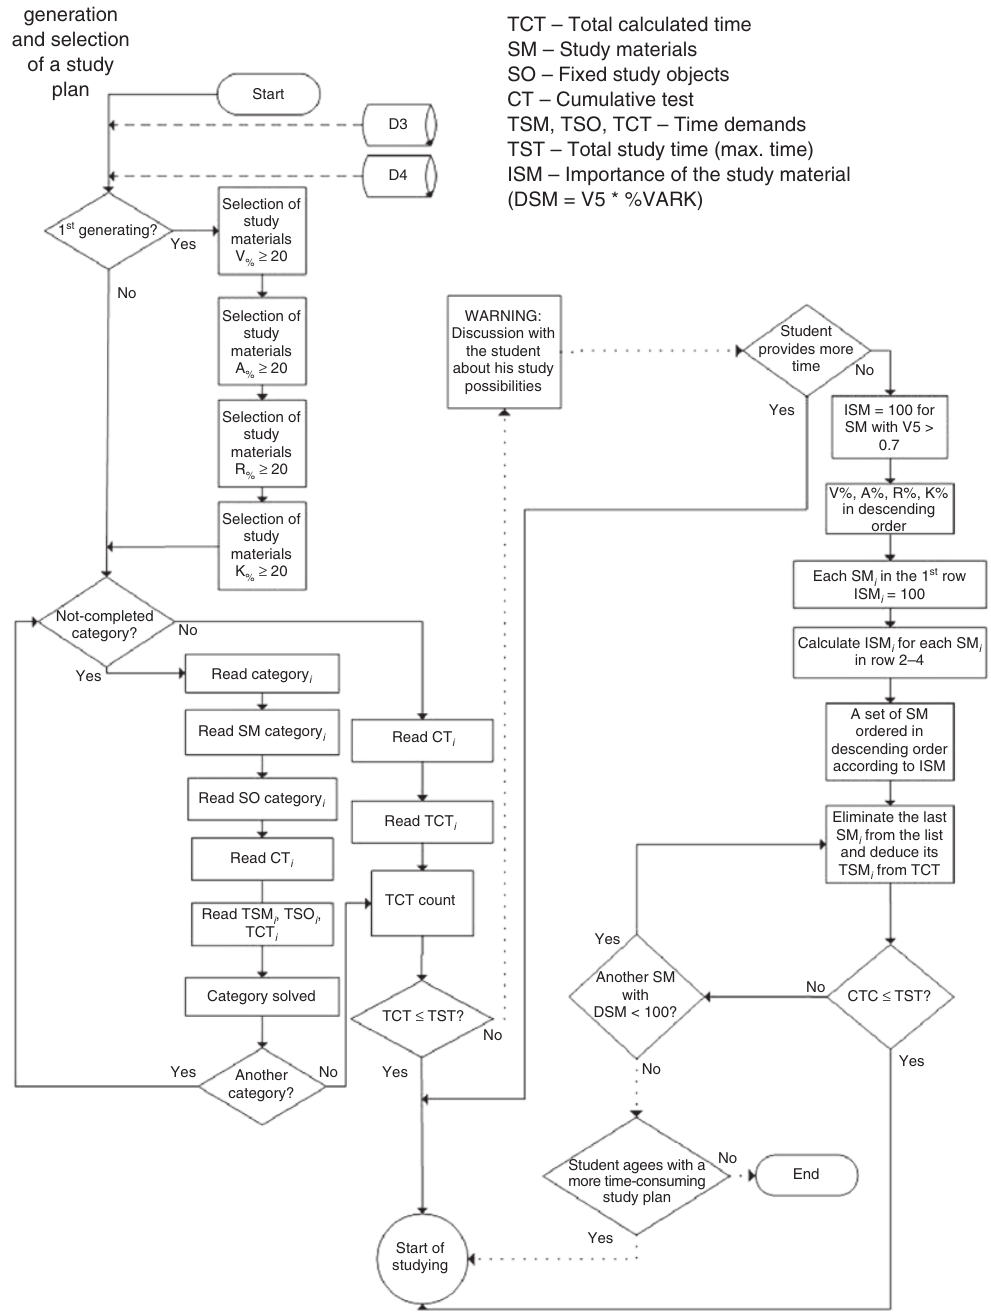
Figure 2: Flowchart of the Whole M3 Process of Generating a Study